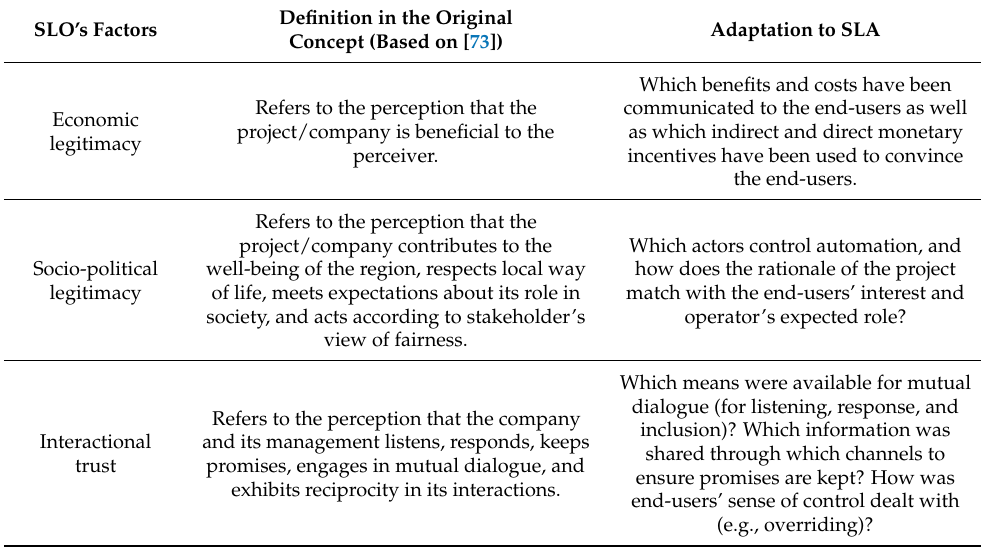
Table 1. Adaptation of the SLO original concept to automated DSM (social license to